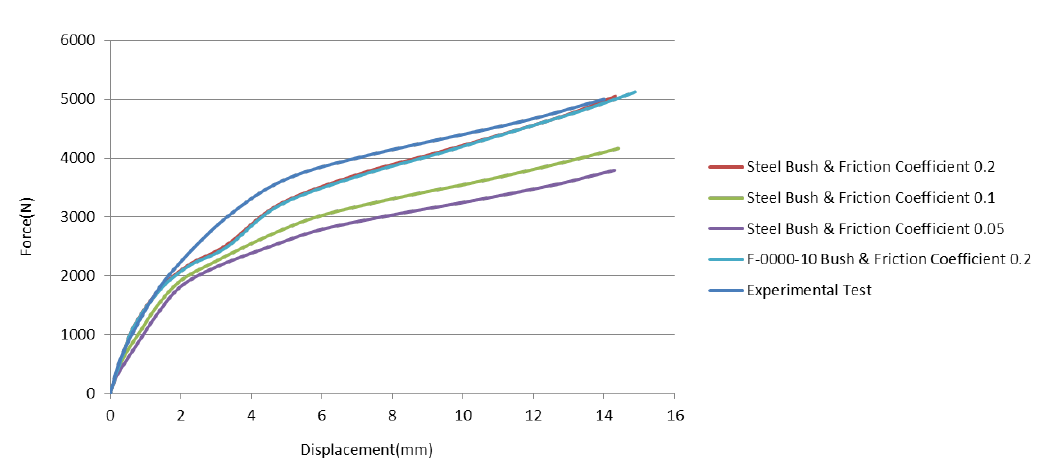
Figure 20. Direction Z force displacement curves according to simulation parameters.